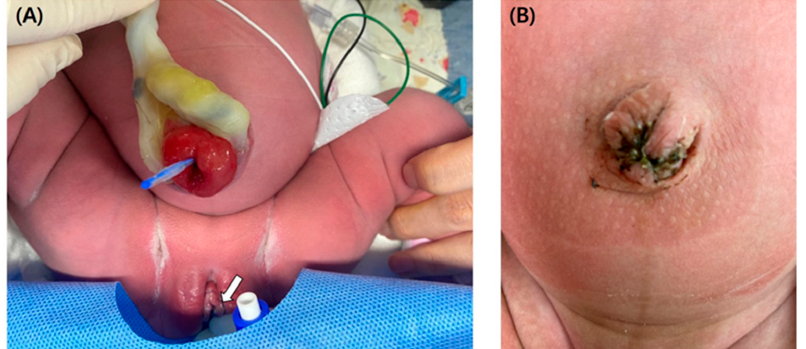
Figure 2. ( A ) Picture of a Foley catheter passing through a ruptured cyst at umbilical cord insertion. (The white arrow indicates the beginning of the Foley catheter). ( B ) Picture of umbilicus of neonate after surgery.